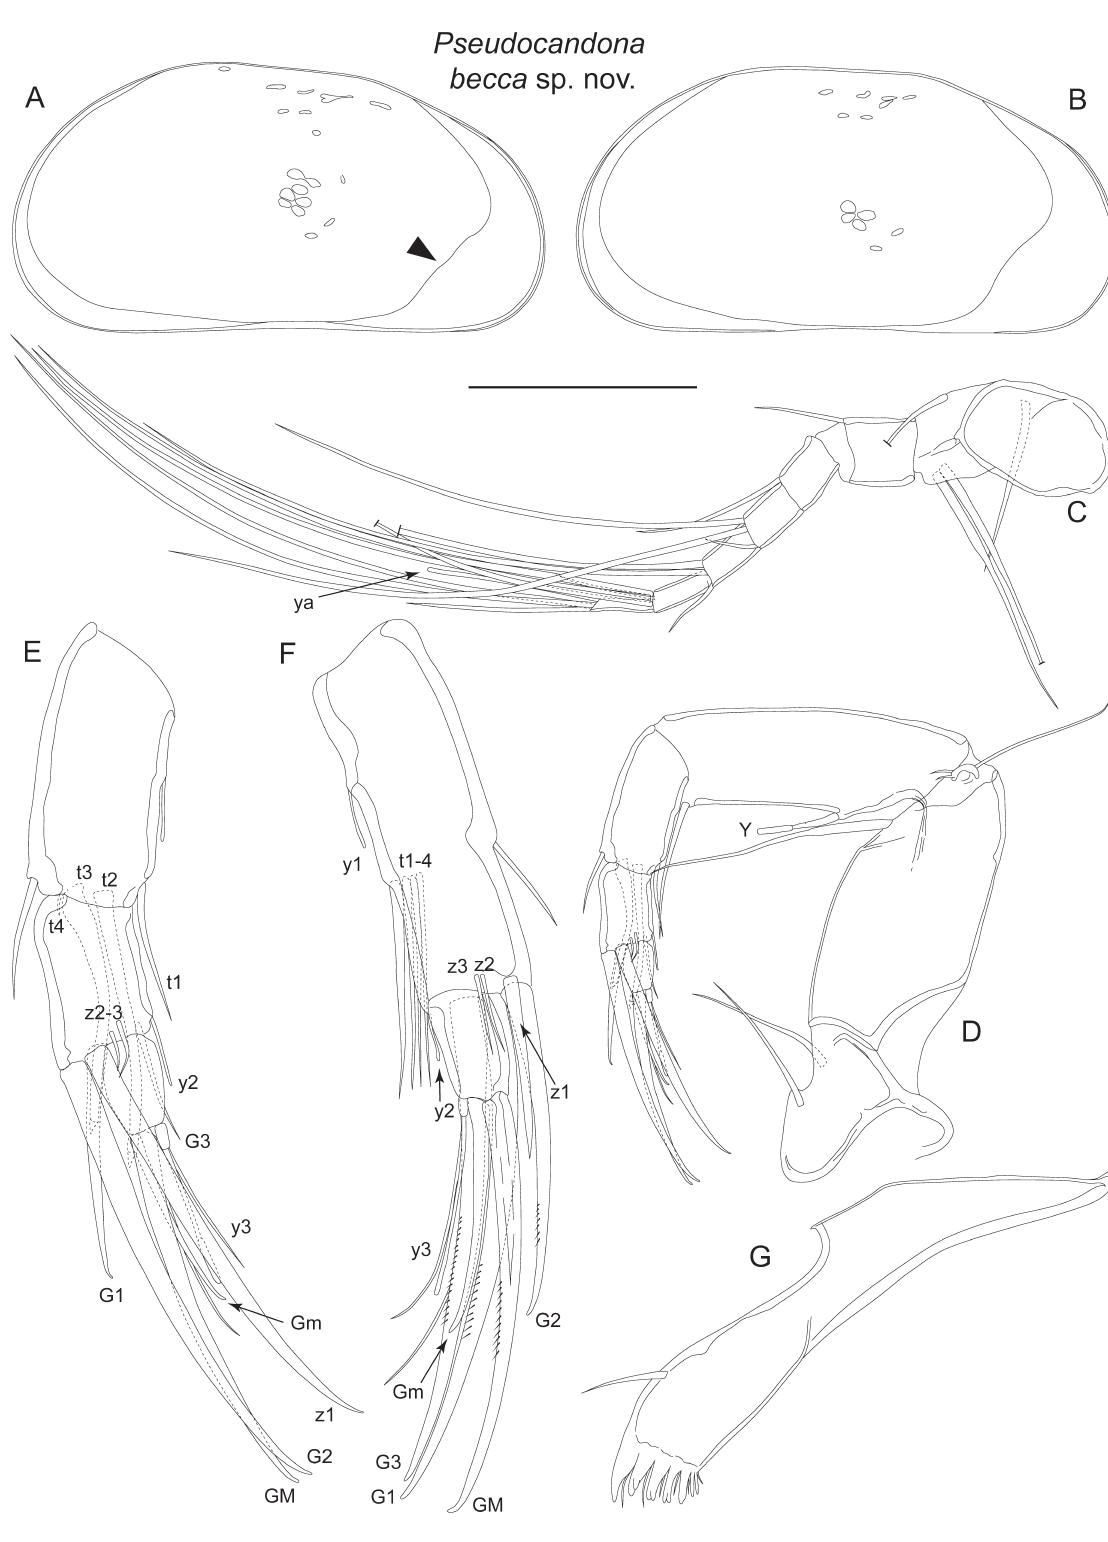
Fig. 3. Pseudocandona becca sp. nov. A . Internal view of male left valve. B . Internal view of female left valve (LBM 1430006266). C . Male antennule (LBM 1430006264). D . Male antenna (LBM 1430006264). E . Detail of male antenna (LBM 1430006264). F . Detail of female antenna (LBM 1430006266). G . Female mandibular coxa (LBM 1430006267). Scale bar: A–B = 500 µm; C–D, G = 127 µm; E–F = 66